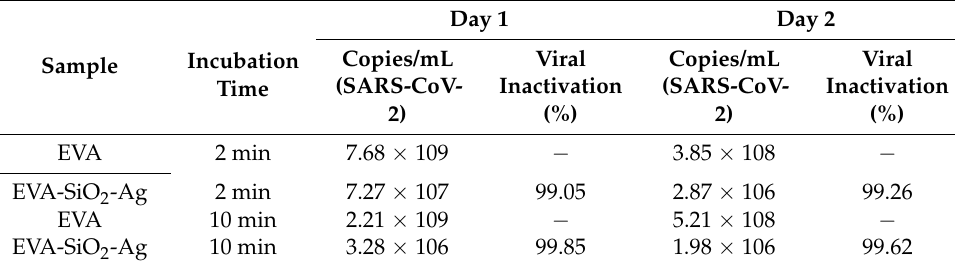
Table 2. Copies per mL of SARS-CoV-2 at different times of incubation.